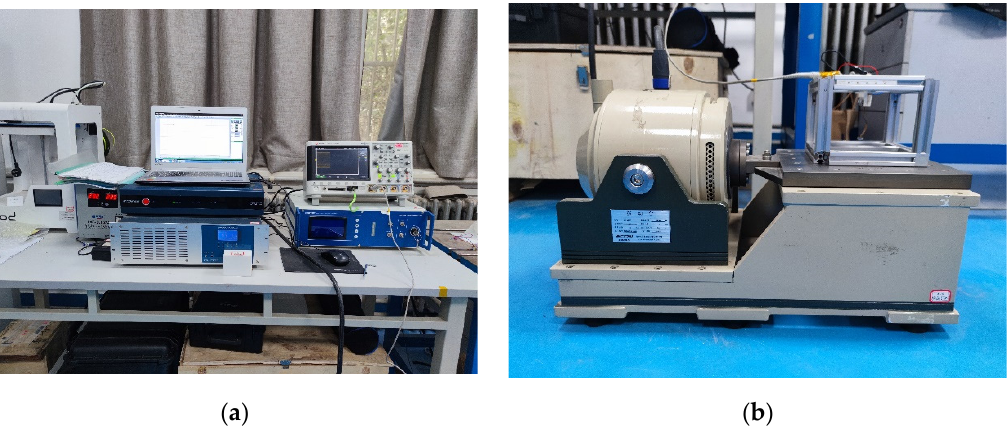
Figure 14. Experimental platform: ( a ) control section; ( b ) vibration table with PEH-C.